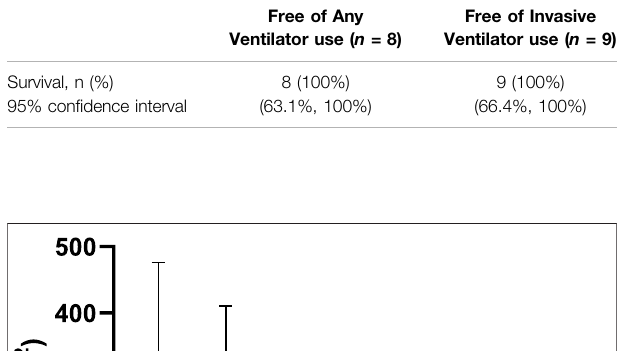
FIGURE 1 | LVMI changes from baseline echocardiography by visit. Data are presented as the mean ± SD. LVMI: left ventricular mass index.